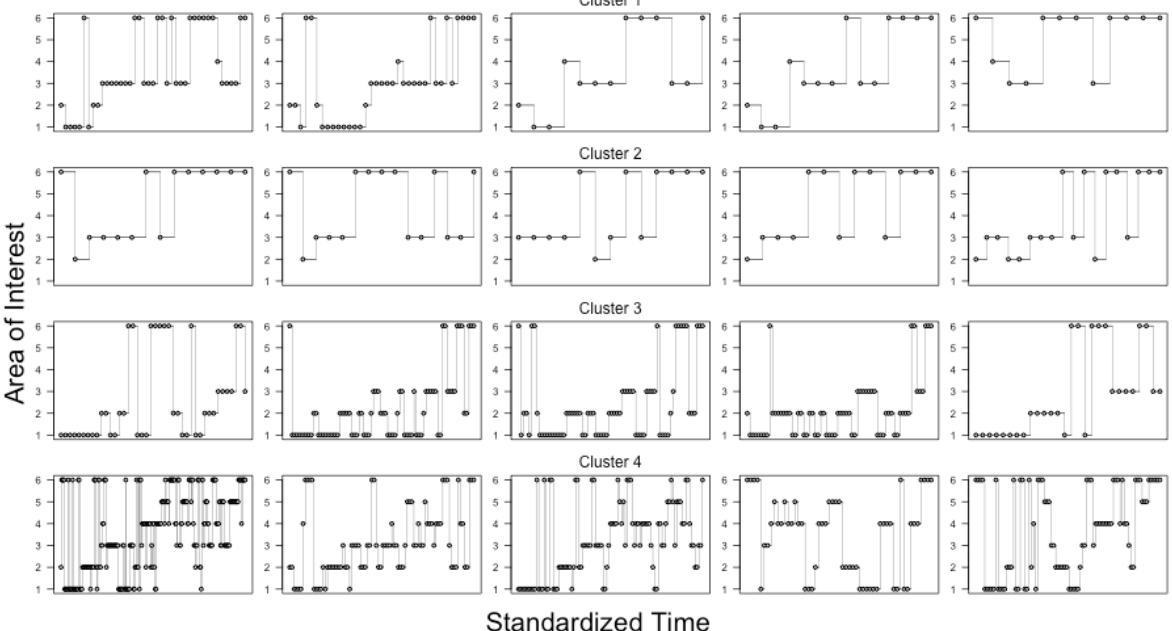
Figure 4. Each row shows five example scanpaths assigned to one of the clusters. Fixations to particular AOIs are shown as dots and transitions are connected with